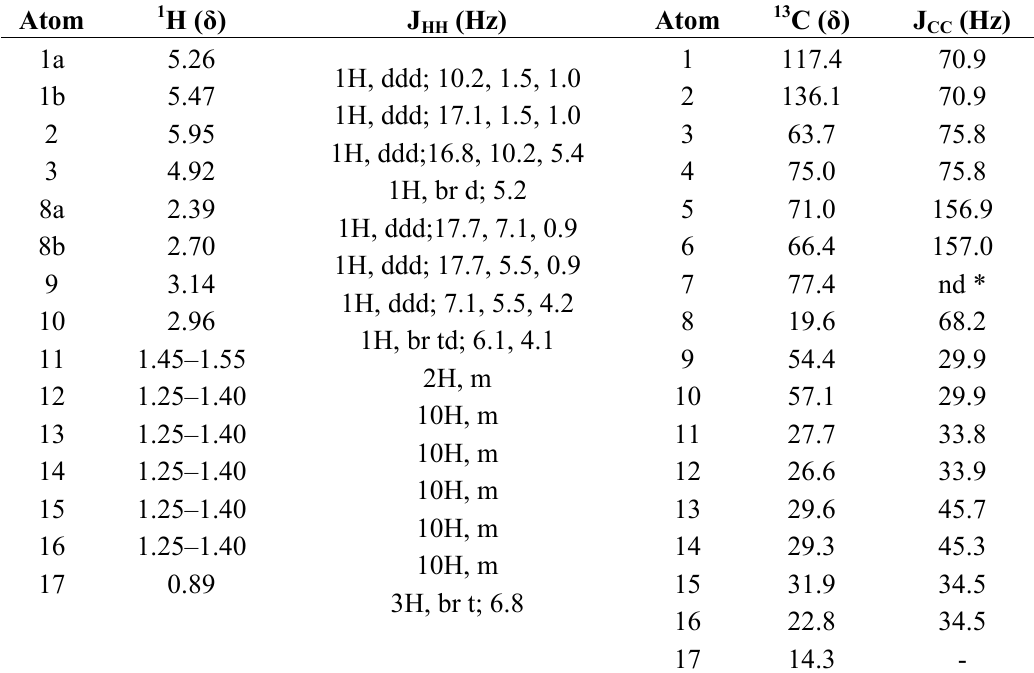
Table 1. 1 H- and 13 C-NMR data of 13 C-labelled panaxynol ( 1 ) (solvent, CDCl